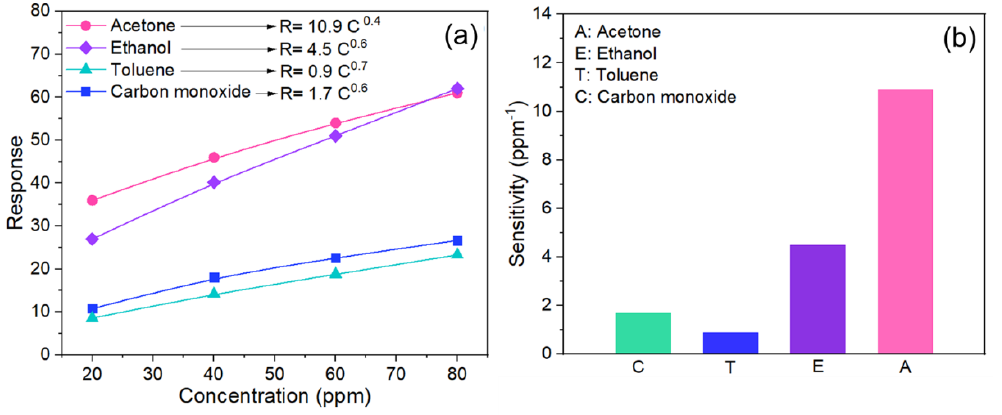
Figure 6. Summary of the gas sensing results obtained at 285 °C for the samples annealed at 450 °C.